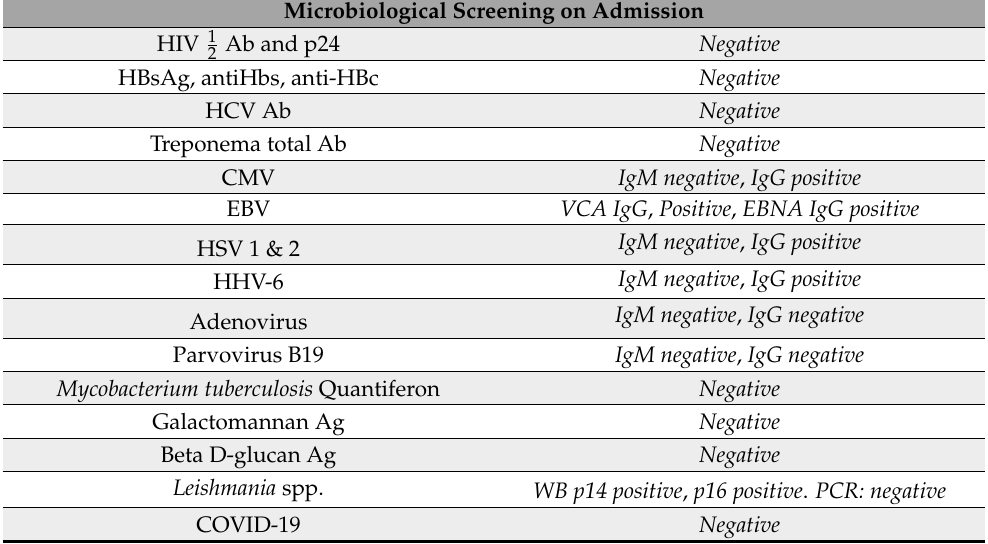
Table 2. Microbiological Screening for Pancytopenia and